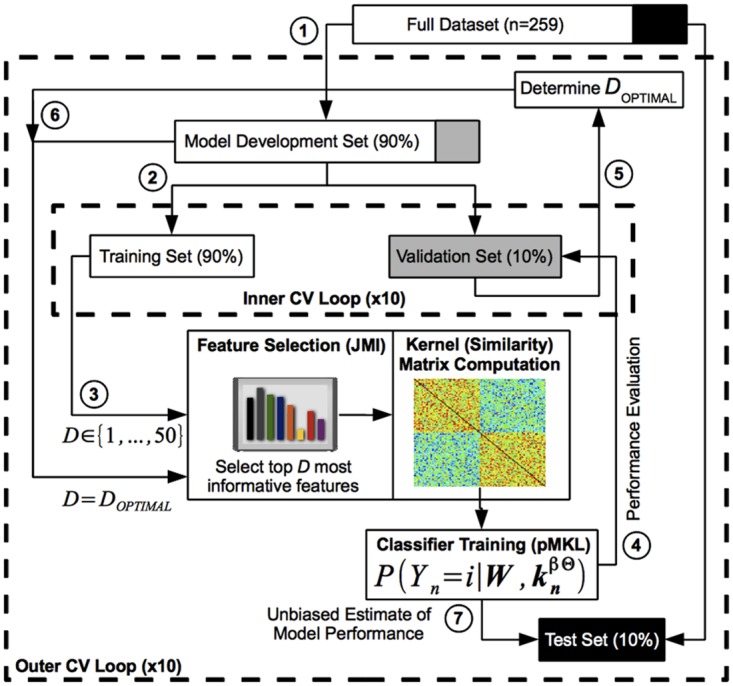
Nested 10-fold cross-validation (CV) procedure for model development and evaluation.(1) In the outer CV loop, the dataset was partitioned into the 'Model Development Set' and 'Test Set'. (2) In the inner CV loop, the 'Model Development Set' was further partitioned into the 'Training Set' and 'Validation Set'. (3) Several classifiers were trained using only the 'Training Set' and a varying number (1–50) of the most informative features, as identified with the Joint Mutual Information (JMI) method. (4) These classifiers were evaluated on the 'Validation Set', and (5) the number of features that produced maximal classification accuracy was selected as the optimal number of features (DOPTIMAL). (6) The final model was then constructed by training a classifier using the 'Model Development Set' and the optimal number of JMI-based features, DOPTIMAL. (7) An unbiased estimate of model performance was obtained by evaluating the final model on the held out 'Test Set', which was not used during feature selection, model (parameter) selection, or final model construction. Both the outer and inner CV loops used a 10-fold CV design.